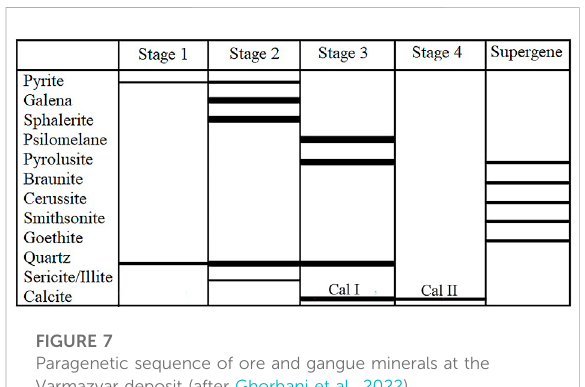
FIGURE 7 Paragenetic sequence of ore and gangue minerals at the Varmazyar deposit (after Ghorbani et al.,